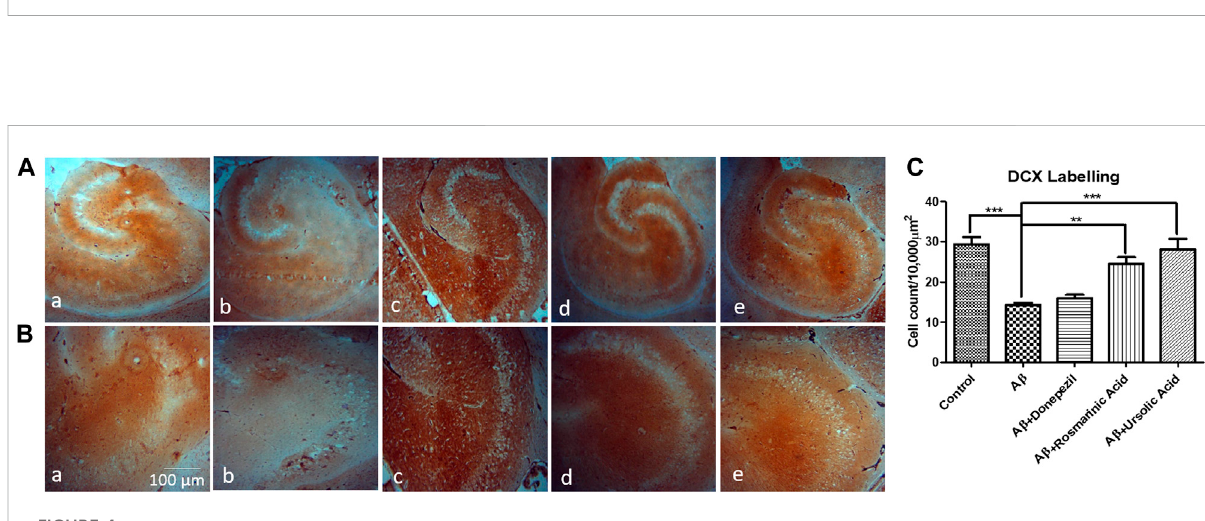
FIGURE 4 Neuron-speci fi cDCXLabelingofmicehippocampaltissue:(a)Control(b)A β 1 – 42 -treated group(c)A β 1 – 42 + donepezil-treated group(d)A β 1-42 + RA-treated group (e) A β 1 – 42 +UA-treated groups at magni fi cation (A) 4X (B) 10X (C) Graph showing cell count/10000 µm 2 of DCX labelled cells in mice hippocampus in experimental groups respectively. Signi fi cance was analyzed by One-way ANOVA followed by Bonferroni comparison test (mean ± SEM) using GraphPad Prism. ** p < 0.01, *** p <